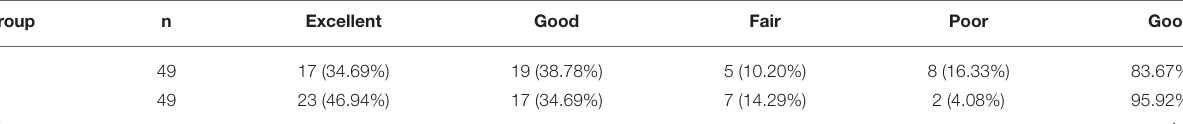
TABLE 3 | Fracture reduction quality [n(%)].